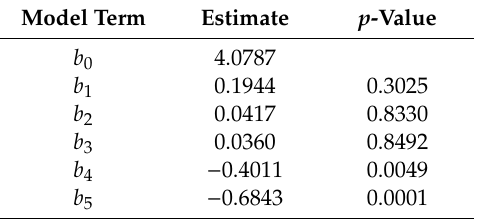
Table 3. Regression coe ffi cients and p -values for the independent variables in the regression